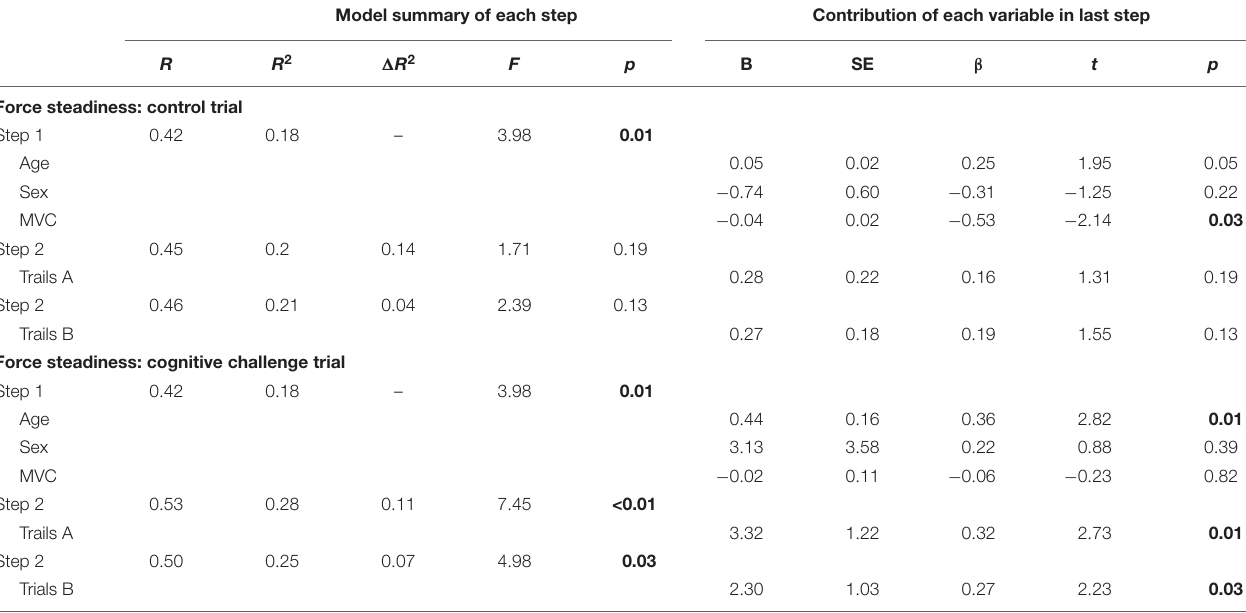
TABLE 3 | Hierarchical regression analyses predicting performance on force steadiness of older adults. Model summary of each